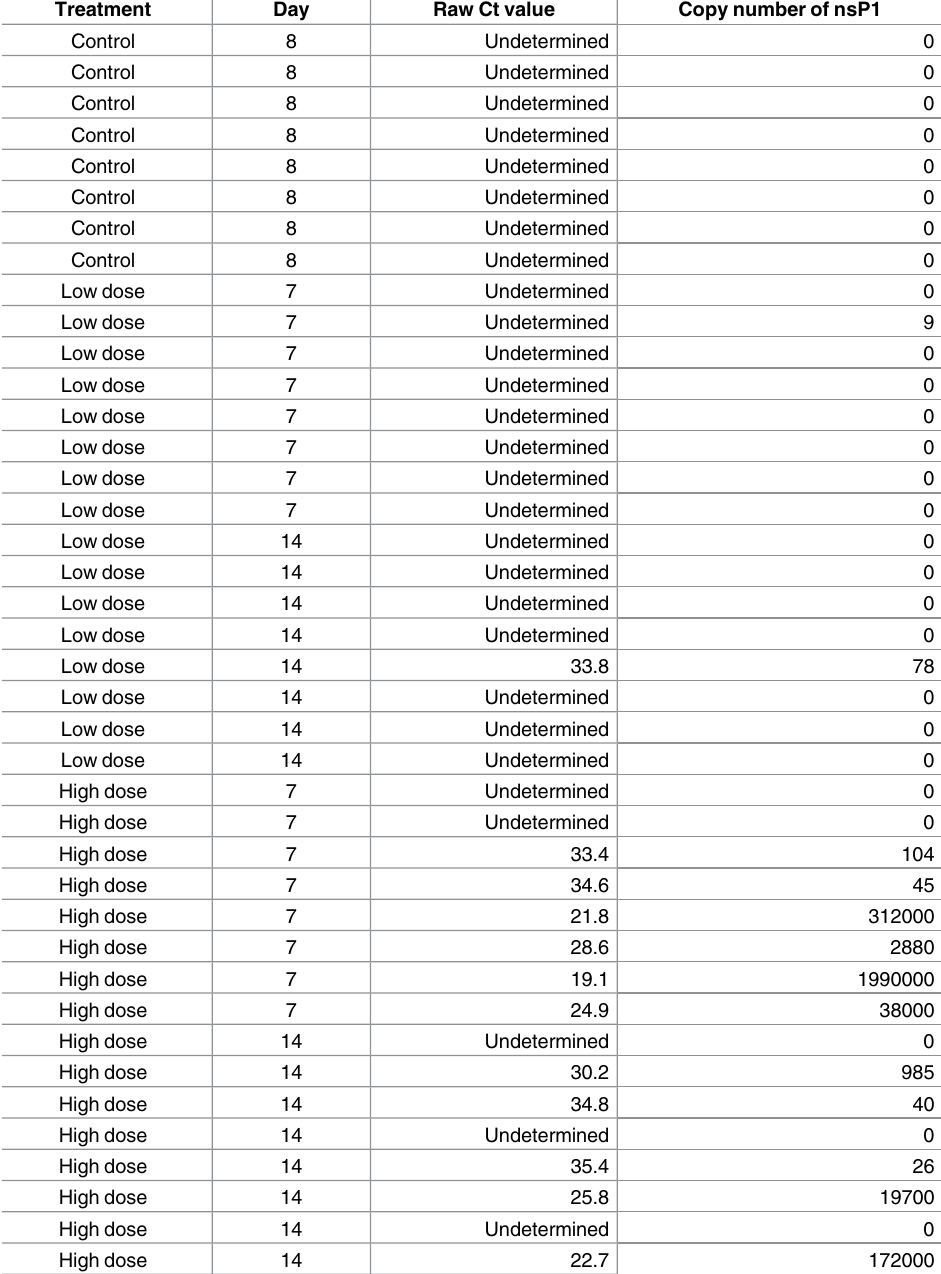
Table 3. Presenceof SAV-3 in the heart tissue of Atlantic salmon used in the present study. SAV-3 copy numberswere estimated by qPCR using the nsP1 gene. Treatment